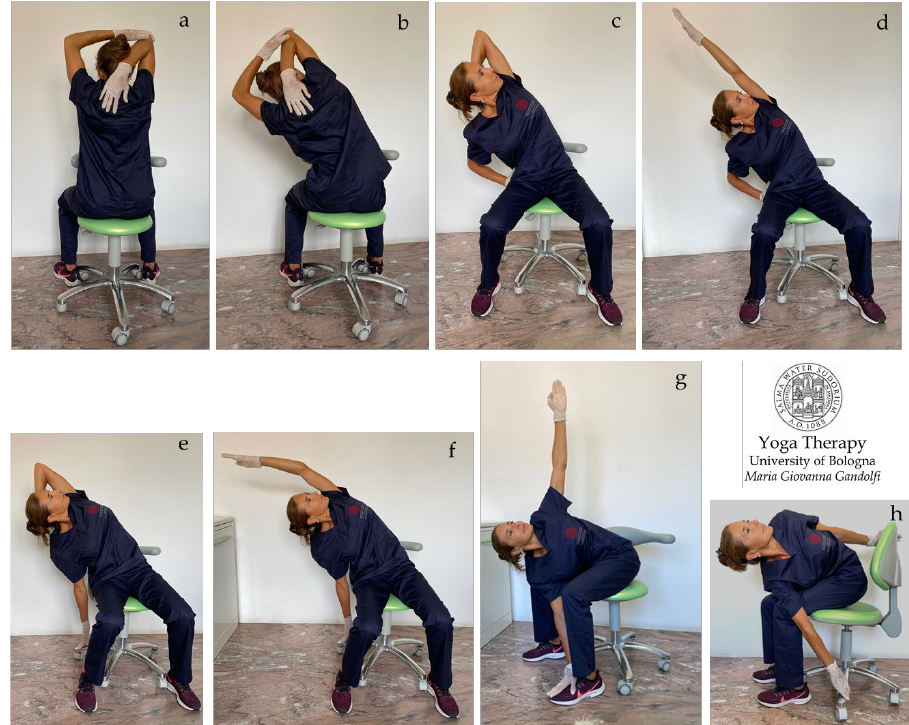
Baddha Utkat ¯ asana ( h